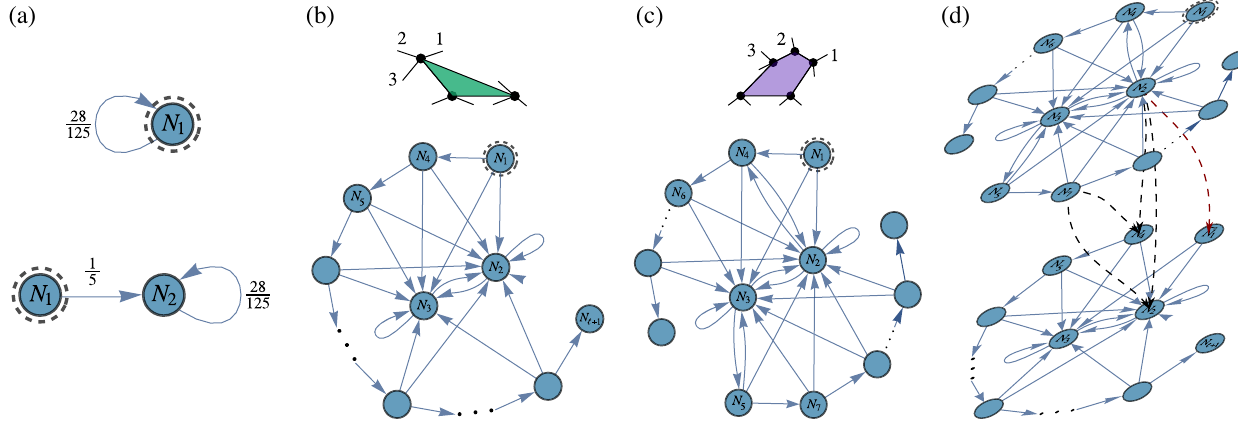
FIG. 15. Graphs G obtained through the GRIM by integrating (a) l center modules M C , (b) l edge modules M E , (c) l middle w modules M M . In panels (b) and (c), we indicate how the wires are labeled. (d) Transition between the middle and the edge graphs of (b) and (c). All the nodes in the middle graph are connected to the nodes N 2 and N 4 on the edge graph. The node N 2 of the middle graph is ˆ N also connected to a node 1 that connects to the rest of the edge graph.